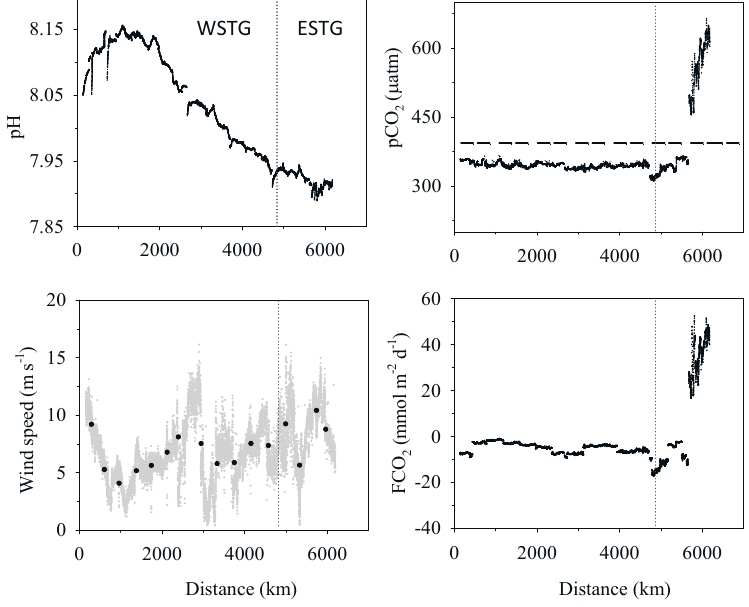
Figure 4. Changes in sea surface pCO 2 , sea-air CO 2 flux, pH and wind speed with distance along then transect. The dashed horizontal line is the mean atmospheric pCO 2 value during the campaign (396.5 μ atm). Round dots indicate mean daily wind speed values (used for flux calculations). In each graph the dotted line demarcates the western and eastern parts of the subtropical gyre (WSTG and